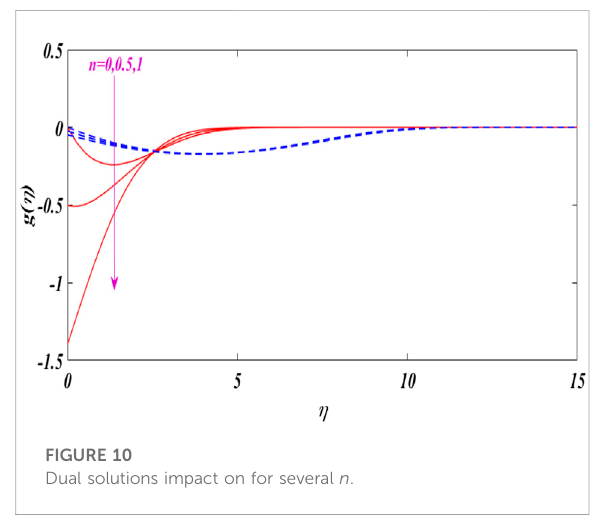
Dual solutions impact on for several n